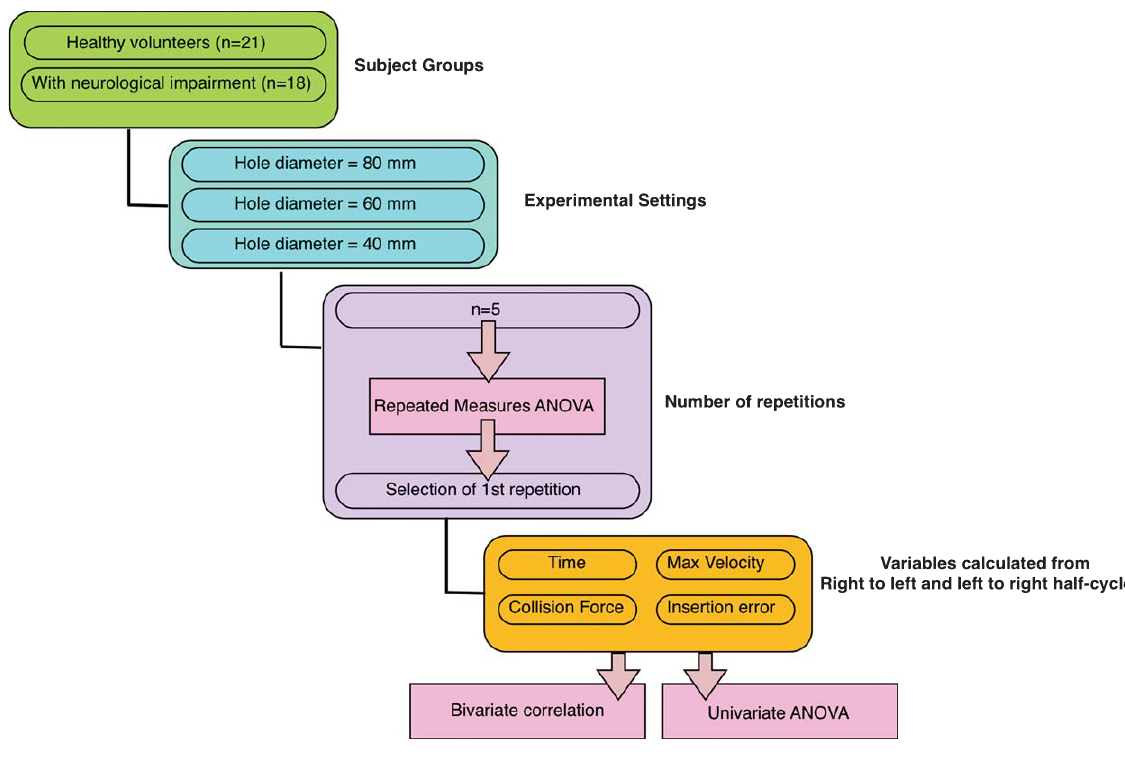
Fig. 5. Study setup versus gathered and analysed